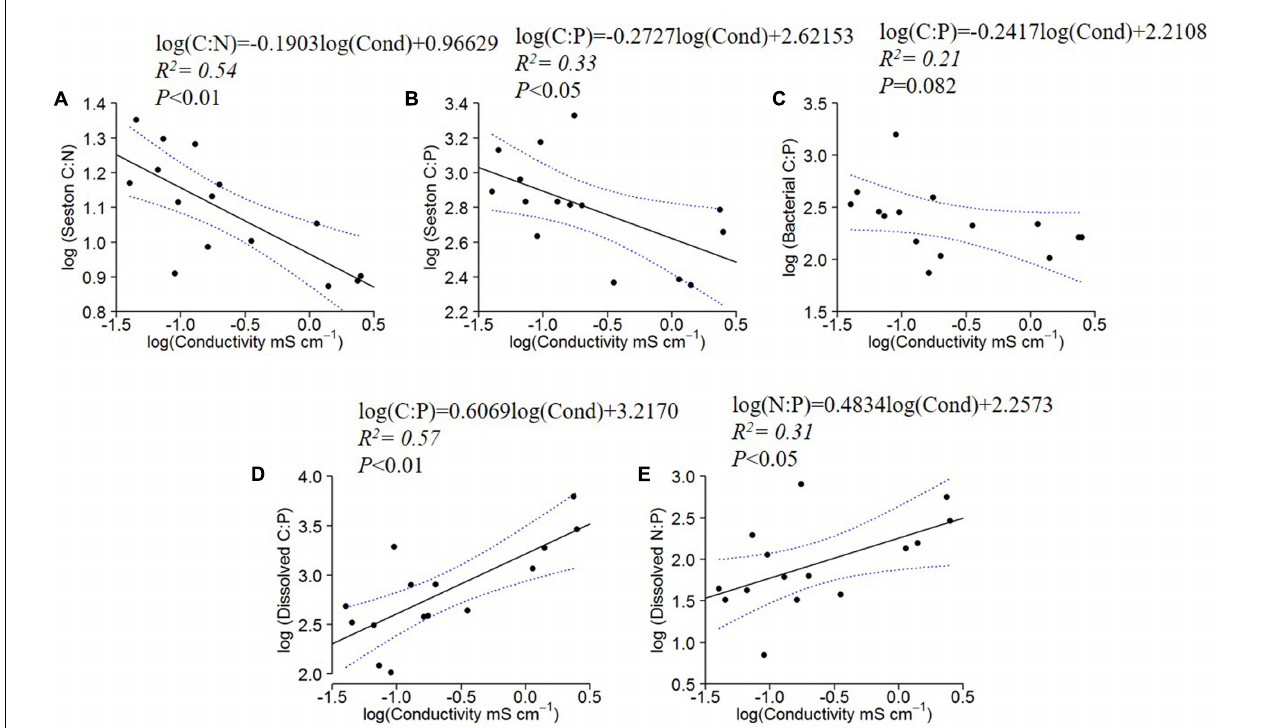
FIGURE 3 | Log 10 linear regressions of seston C:N and C:P against specific conductivity (A,B) , bacterial C:P against specific conductivity (C) and dissolved C:P (D) and N:P ratios (E) against specific conductivity (residence time). The regression fit is indicated by black solid lines and 95% confidence intervals by blue dotted